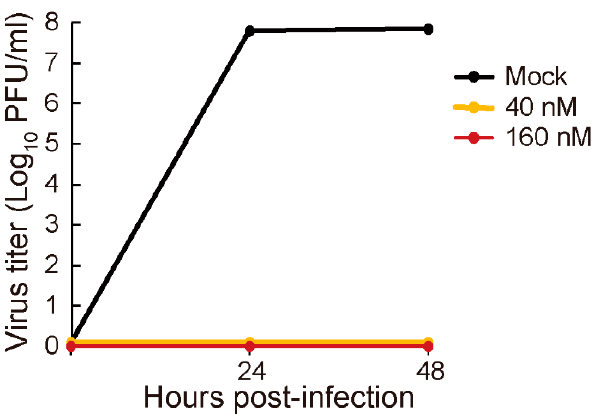
Figure 1. Virus growth kinetics in the presence of baloxavir marboxil. MDCK cells were infected with A/Guangdong/17SF003/2016 virus at an MOI of 0.001 and incubated with baloxavir marboxil at 0, 40, or 160 nM. At 24 and 48 h post infection, virus titers in the culture media were determined by means of plaque assays. Virus titers are expressed as means ± SD ( n = 3).